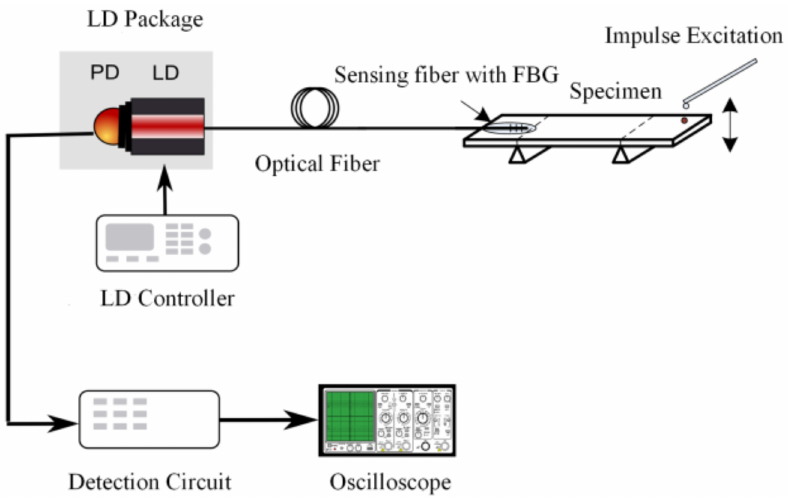
Figure 6. Experiment setup for measurement of Young’s modulus and internal